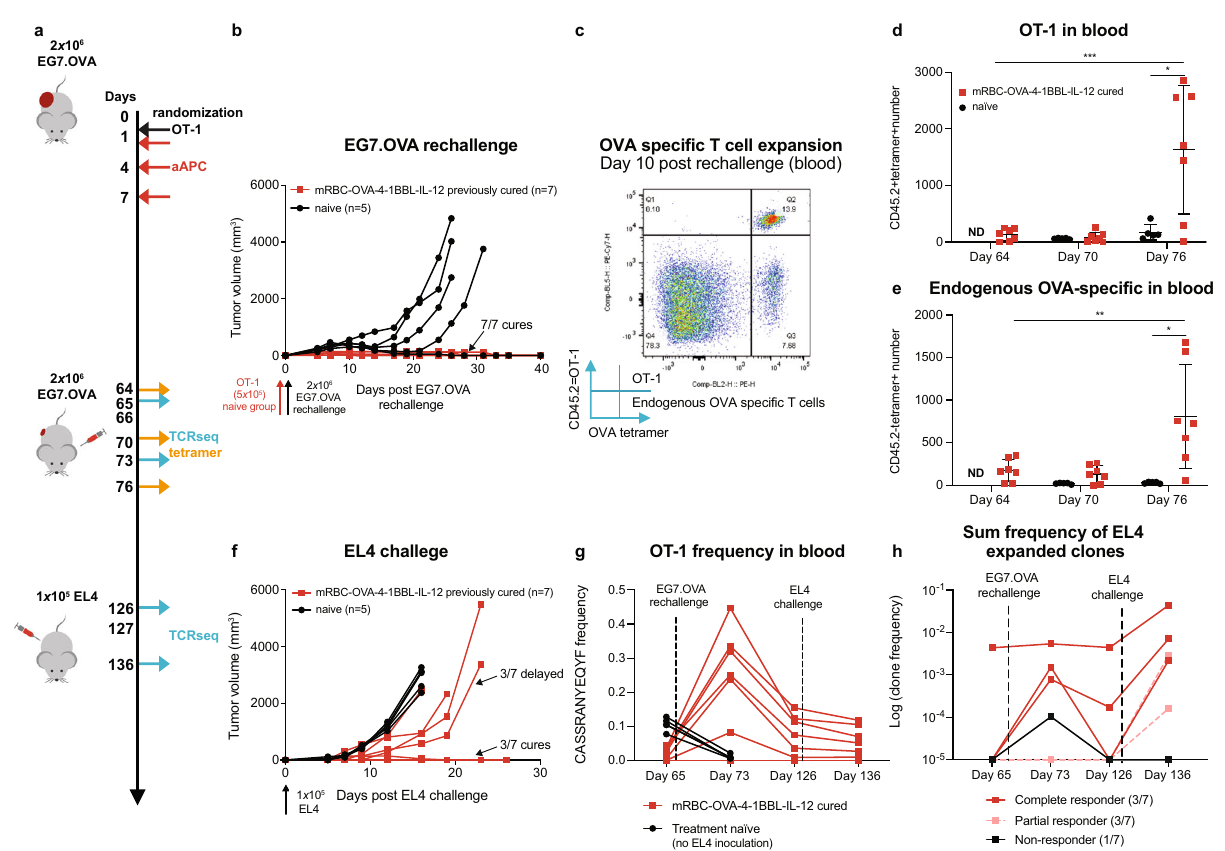
Fig. 3 mRBC-OVA-4-1BBL-IL-12 promotes immune memory and epitope spreading, and harnesses endogenous T cells. a CD45.1 Pep Boy mice were randomized when EG7.OVA tumors reached ~230 mm 3 ( n = 8), treated with naïve OT-1 cells, and dosed with 2.5 × 10 8 mRBC-OVA-4-1BBL-IL-12. Seven out of eight mice cured of original EG7.OVA tumors and were rechallenged on day 66 with EG7.OVA. Age-matched naïve CD45.1 Pep Boy mice ( n = 5) were treated on day 65 with 5 × 10 5 naïve OT-1 cells 1 day before challenge with EG7.OVA cells, as controls. b All previously cured mice rejected EG7.OVA rechallenge. c Representative fl ow cytometry plots showing OT-1 and endogenous OVA-speci fi c T cells in 50 μ L of peripheral blood 10 days after EG7.OVA rechallenge (Day 76). d OT-1 and e endogenous OVA-speci fi c T-cell numbers in 50 μ L peripheral blood 2 days before rechallenge (Day 64), 4 days post rechallenge (Day 70), and 10 days post rechallenge (Day 76). One-way ANOVA compared to day 64; OT-1: day 75 P = 0.0009; endogenous OVA- speci fi c: day 75 P = 0.0079. Unpaired two-way Student ’ s t test compared to naïve; OT-1 day 75 P = 0.018; endogenous OVA-speci fi c: day 75 P = 0.018. f At 61 days post-second EG7.OVA challenge on day 127, cured mice ( n = 7) along with age-matched naïve control mice ( n = 5) were challenged with EL4. Three out of seven cured mice had delayed EL4 growth and three out of seven rejected EL4. g TCR β sequencing analyses of OT-1 frequency on days 65, 73, 126, and 136 in the blood. h The signi fi cantly expanded TCR clones after EL4 challenge were tracked throughout the tumor challenges. The log of the sum clone frequencies in individual mice is shown. Data are depicted as mean ± s.d. and are representative of two ( b – f ) or one ( g , h ) independent experiment. Source data are provided as a Source Data fi expansion was signi fi cantly faster when signal 1 was present, i.e., treatment with an anti-programmed cell death protein 1 (PD-1) antibody had no effect on lung metastases compared to mRBC- CTRL. Increased pmel-1 cells were detected in the blood, spleen,